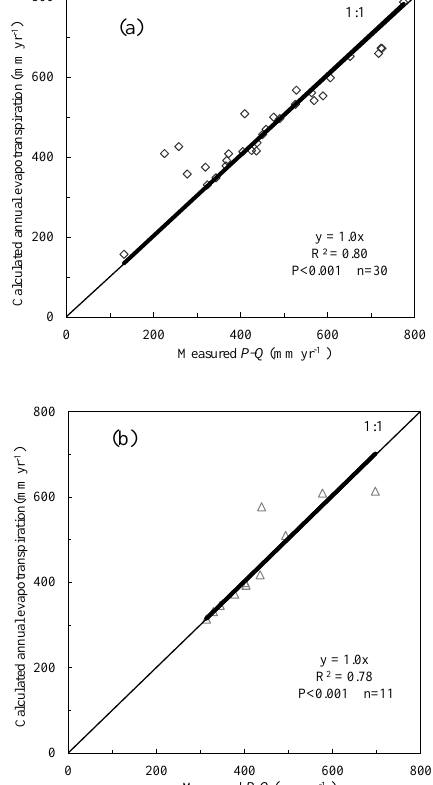
Figure 8. Scatterplots of calculated evapotranspiration using Eqs. (7) and (8) against E a = P − Q during the calibration phase (a) and validation period (b) . The thin line is the 1:1 line, and the bold line is the line of best fit provided by the